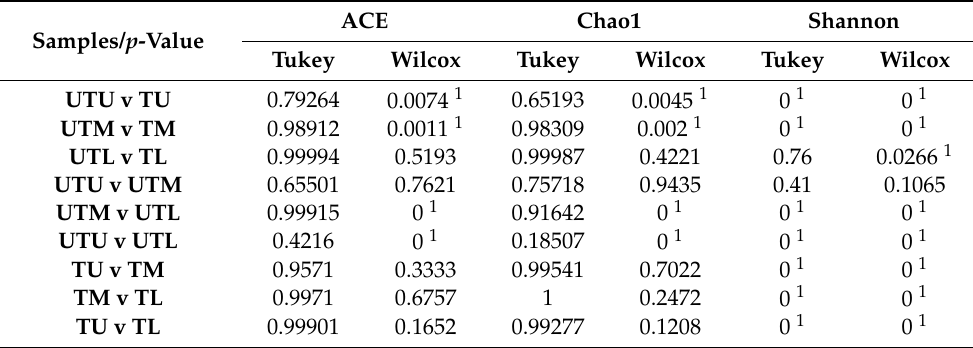
Figure 4. Boxplots depicting three alpha diversity indices. ( A ) Depicts the ACE index, ( B ) depicts the Chao1 index and ( C ) depicts the Shannon index. Table 1. Statistical significance of ACE, Chao1 and Shannon Indices, which were tested via the Tukey and Wilcox